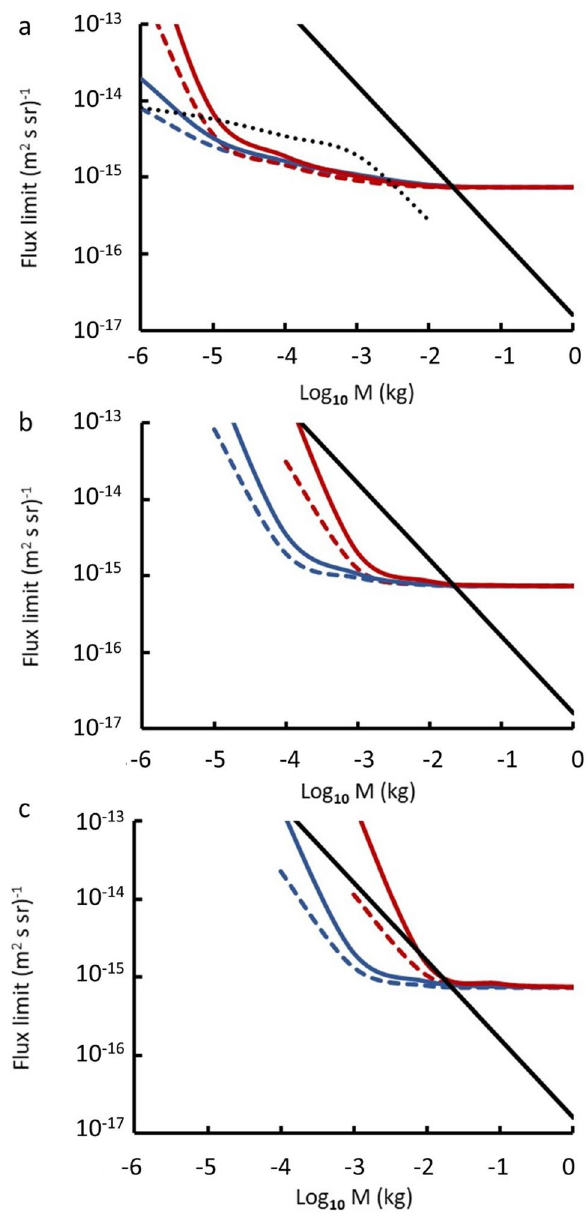
Figure 4. Flux limits as a function of MQN mass for 3 different surface magnetic fields B o of the MQN: ( a ) 0.1 TT, ( b ) 1.0 TT, and ( c ) 3.2 TT. The blue (red) lines are for MQN density of 10 18 (3 × 10 17 ) kg/m 3 . Two curves for each density show the observationally determined limits with zero streaming velocity (solid) and with a streaming velocity of 230 km/s through the Galaxy (dashed). The solid black line is the theoretically expected flux on the GSL assuming all the DM is made up of MQNs of a fixed mass. The black dotted line is the integrated flux greater than the mass on the abscissa theoretically predicted from the Aggregation Model (see text) for B o = 0.1 TT. Curves for higher B o have flux limits < 10 –17 m 2 s -1 sr -1 (do not fit on the plots) and are not constrained by the experimental flux limits. Values of B 0 > 3.2 TT were excluded as described in Ref. 14